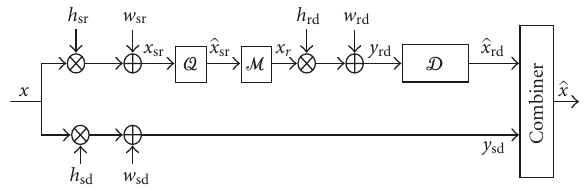
replaced with a linear function in the AF case and a nonlin- ear function in the clipped AF case (Section